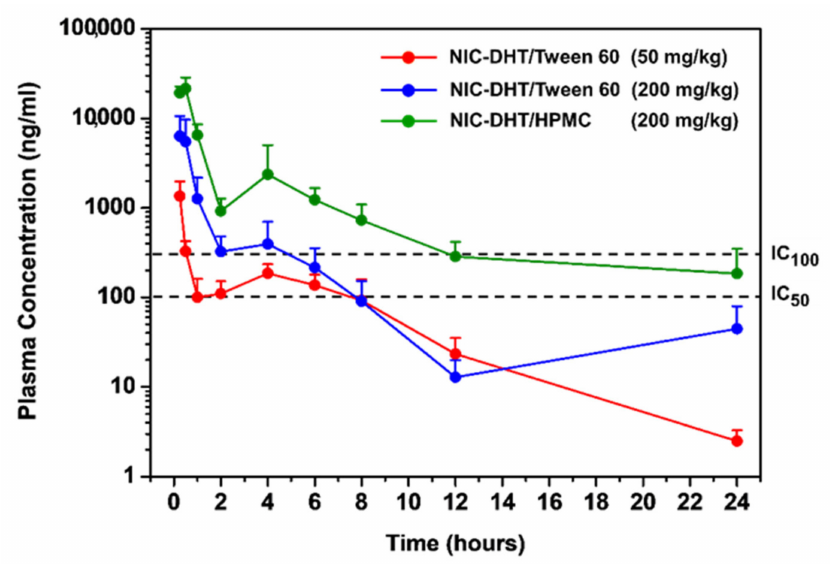
Figure 6. Plasma NIC concentration–time profiles after a single oral administration of NIC–DHT/Tween 60 nanohybrid (50 mg/kg and 200 mg/kg) and NIC–DHT/HPMC (200 mg/kg) in rats (The data were presented as the mean ± standard deviation, n =